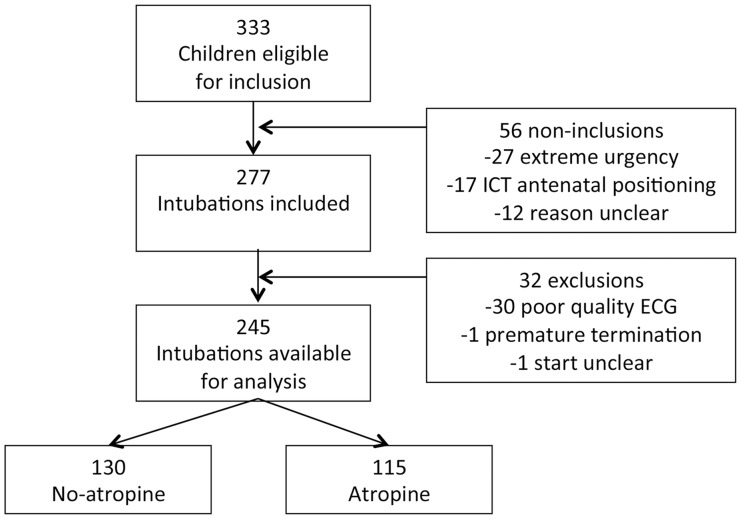
Flow chart of inclusions, non-inclusions and exclusions with the number of intubations available for analysis according to atropine use.